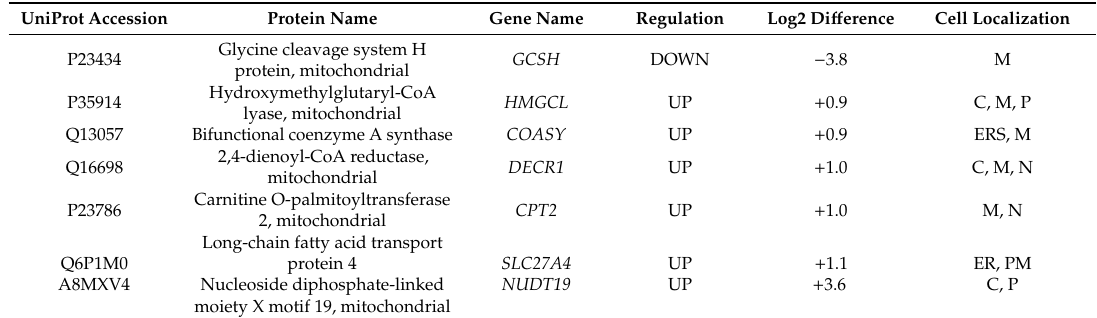
Table 5. Dysregulated proteins in MUT-KO involved in mitochondrial